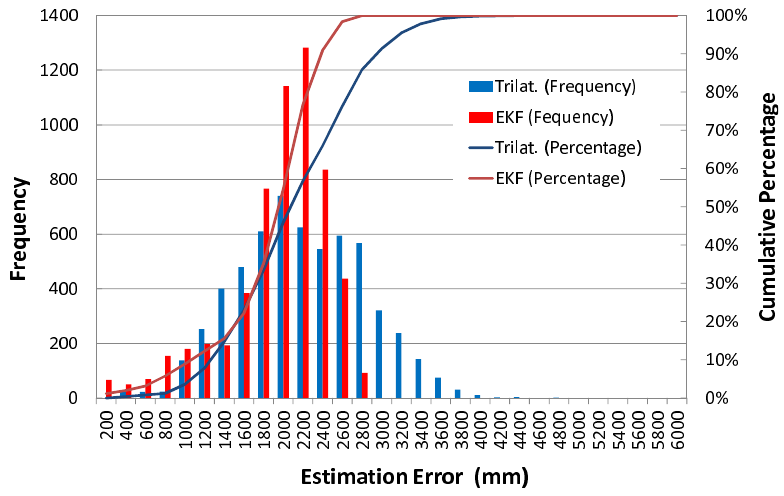
Figure 15. Histogram of pedestrian position estimation error.